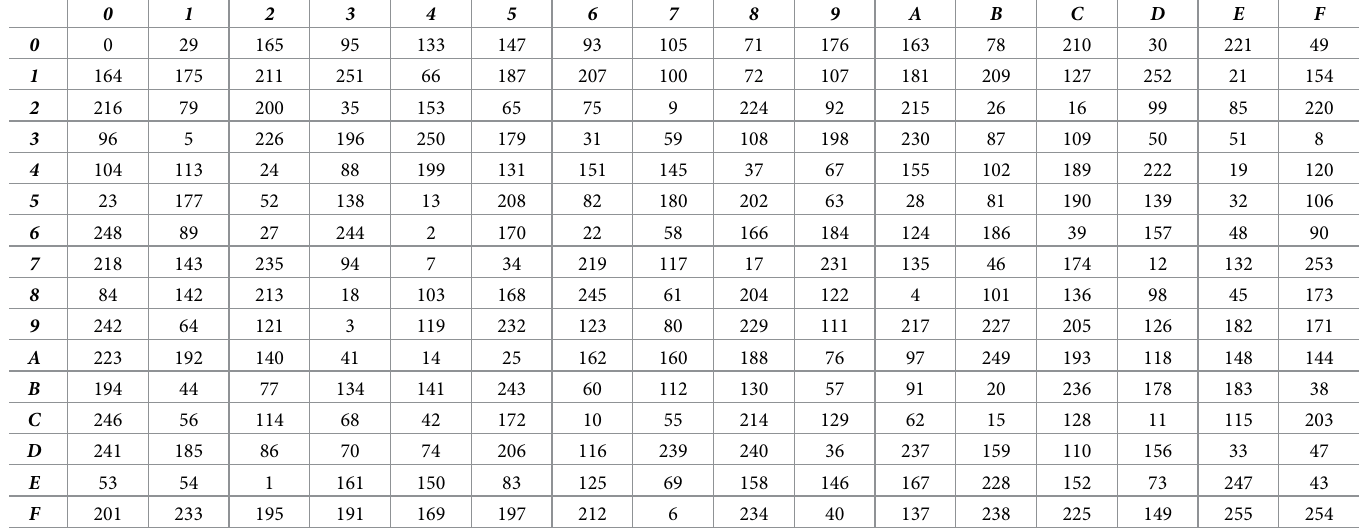
Table 4. Proposed S-box (S3) in 16 × 16 matrix form—Generated with T 3 .